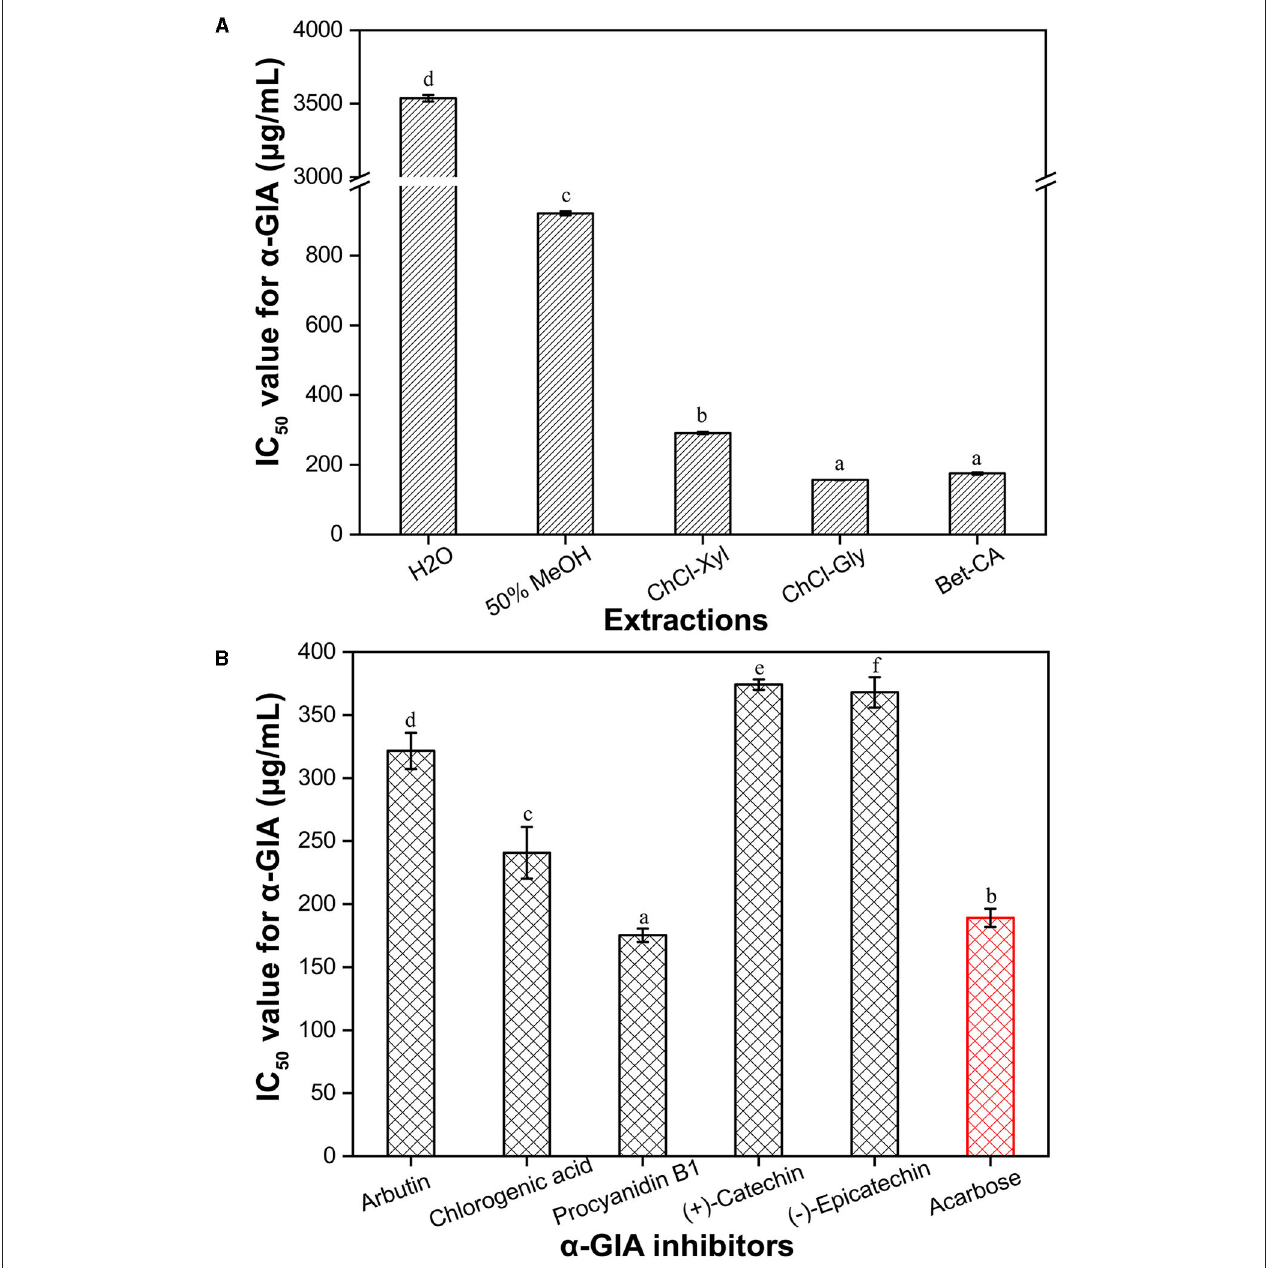
FIGURE 3 | IC 50 values for α -glucosidase inhibitory activity ( α -GIA) of the CIOPs extracts (A) and the main phenolic compounds (B) in the extractions. Ethyl acetate (EtAc) extracts, no inhibitory activity. Different lowercase letters (a–e) mean statistically significant differences. from 1.743 to 2.468 Å) interactions with eight key amino acid amino acid residues (ASP 307, ASP 352, ARG 442, GLN 279, residues of ASP 69, ASP 215, ASP 352, ARG 442, GLN 353, GLN 353, GLU 277, HIS 280, THR 306, and TYR 158). The GLU 277, and GLU 411 of the receptor ( Figure 4E ; Table 5 ). distance of H-bonds ranged from 1.766 to 2.613 Å ( Figure 4C ; Table 5 ). ( + )-Catechin, with a T-score of 6.01, generated four As an anti-diabetic drug, acarbose with the highest T-score of 11.45 represented the extremely strong interactions with α - H-bonds (average distance was 2.229 Å) with six catalytic glucosidase and generated 10 H-bonds (average distance of residues (ASP 215, GLU 277, GLU 411, GLN 279) of the receptor ( Figure 4D ; Table 5 ). (–)-Epicatechin, with a T-score value of 5.66, indicated nine H-bonds (H-bond distance ranging